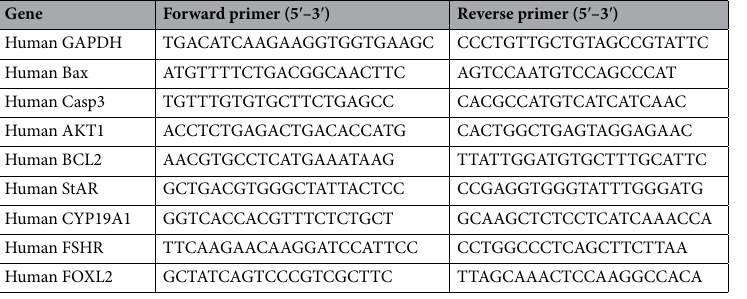
Table 1. Primer list for